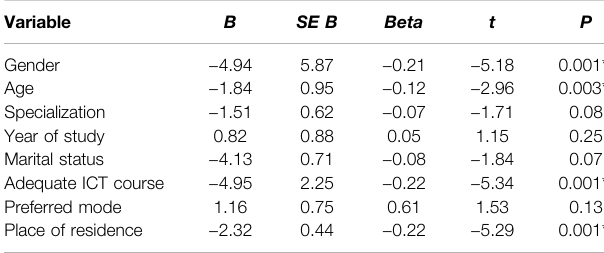
TABLE 6 | Summary of demographic variables predicting the need for OL.